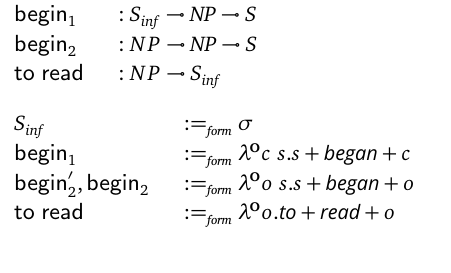
Interpretation of types and